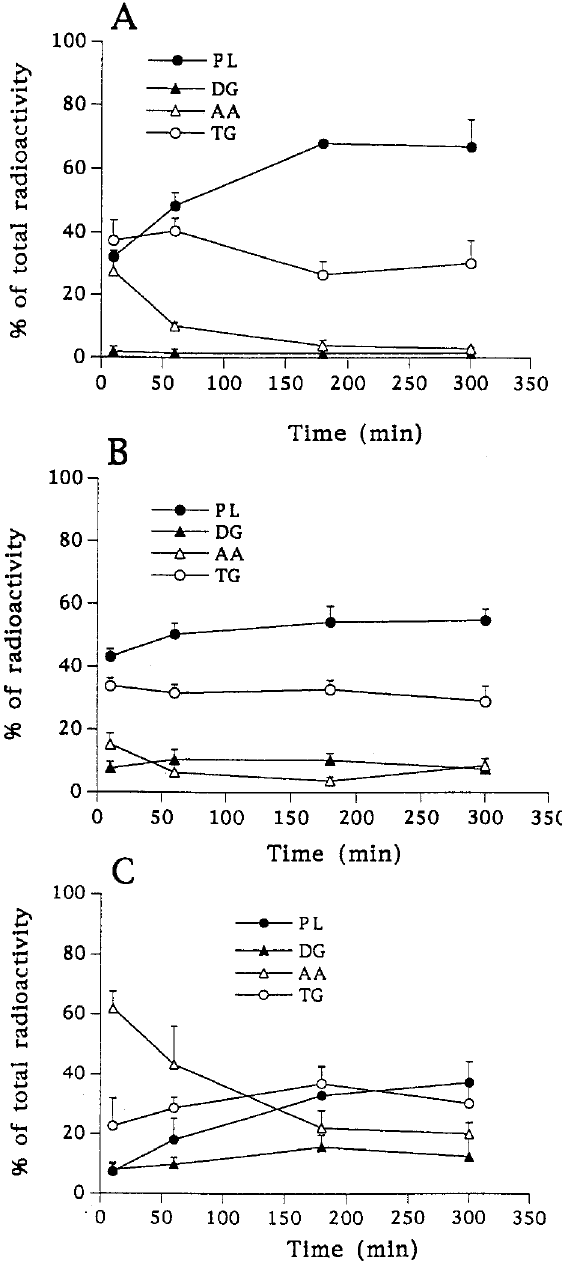
FIG.1. Time-course of [ 3 H]-AA incorporation into bone mar- row mononuclear cells (A), blood mononuclear cells (B) and erythrocytes (C). Cells were incubated with [ 3 H]-AA for 10min, 1, 5, or 24h. Lipids were extracted and separated as described in Methods. Results are expressed as the per- centage of total radioactivity found in cells. Mean ± SEM of three independent experiments in duplicate. PL: phospho- lipids; DG: diglycerides; TG: triglycerides; AA: arachidonic acid.